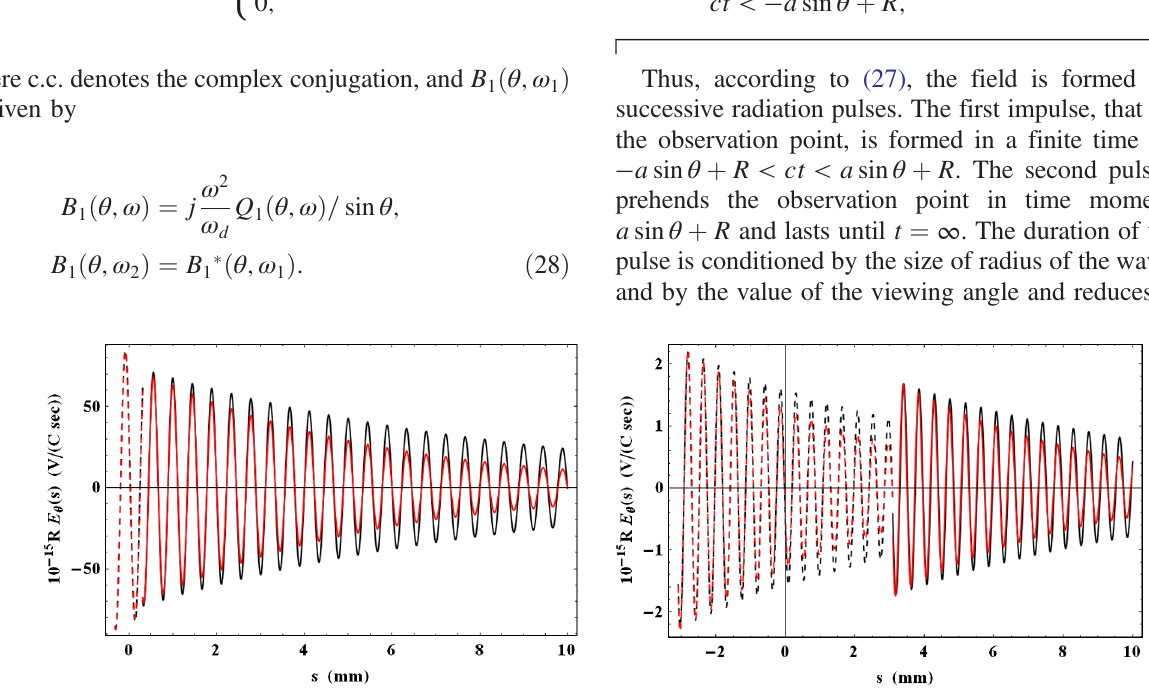
FIG. 3. Spatial-temporal distribution of the radiation field at fixed angles of observation; θ ¼ π = 100 (left), θ ¼ π = 10 (right); first pulse (dotted line), second pulse (solid line); ς ¼ 1 (black line), ς ¼ 3 or ς ¼ 1 = 3 (red